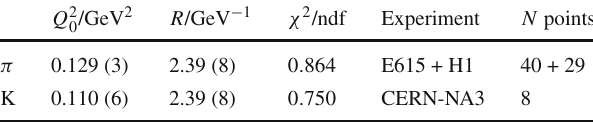
Table 1 The obtained input scale Q 2 and the parton–parton correlation 0 length R for the pion and the kaon, from the fittings to the popular experimental data up to date. The errors in the table indicate the 1